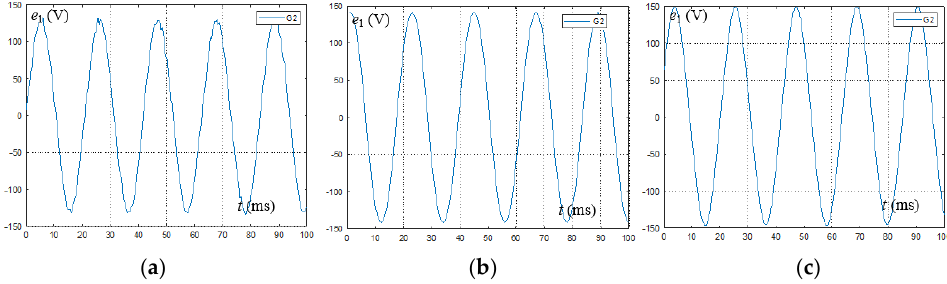
Figure 21. Waveform of induced EMF (phase 1) for the oblique model G2: ( a ) numerical calculations FEM; ( b ) analytical calculations; ( c ) laboratory measurements.